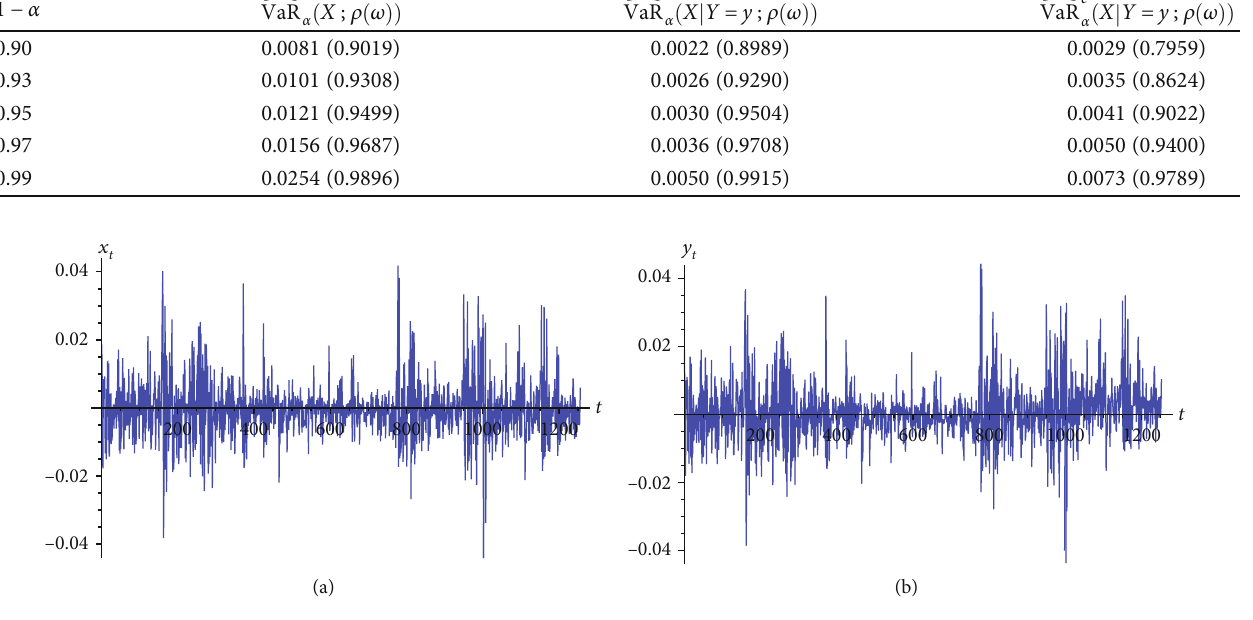
Figure 14: The time series plot of the negative daily log-returns of the S&P 500 (a) and Dow Jones (b) indexes. Table 8: The (conditional) estimative VaR forecast and its coverage probability (in the bracket) of the negative daily log-returns of the S&P 500 index, given the negative daily log-returns of the Dow Jones index, by assuming ARCH(1)